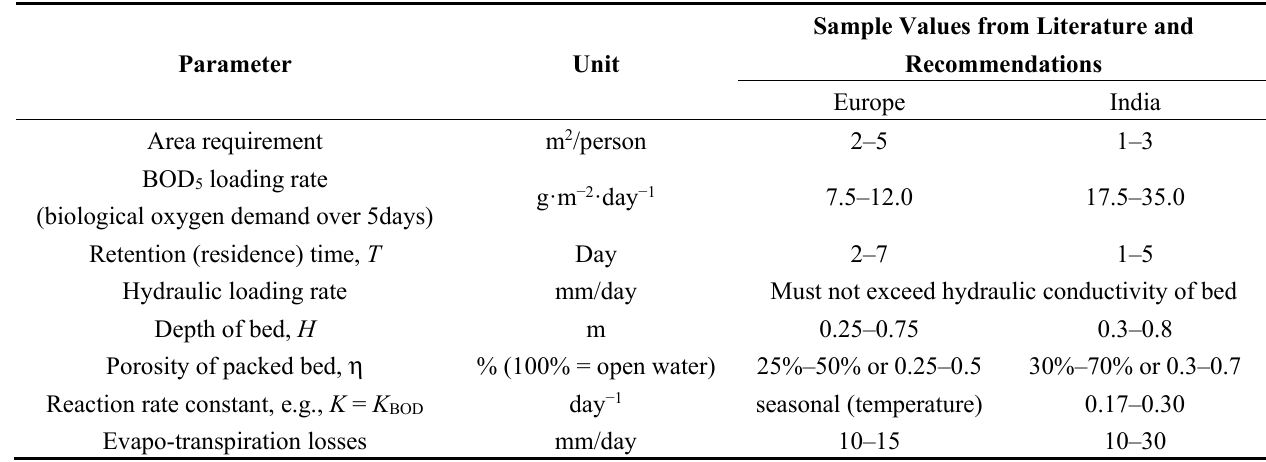
Table 2. Design parameters for constructed wetlands for domestic wastewaters (adapted from